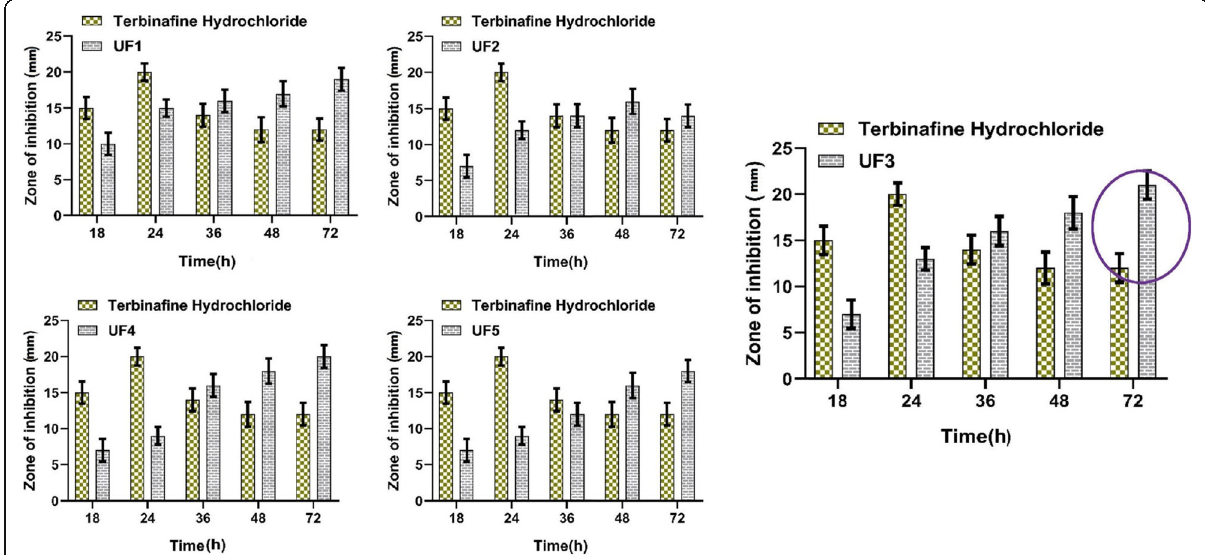
Fig. 5 In vitro antifungal activity of UF1 – UF5 formulation. As expected, UF3 was showing excellent against Candida albicans . Values were expressed as mean ± SD ( n =